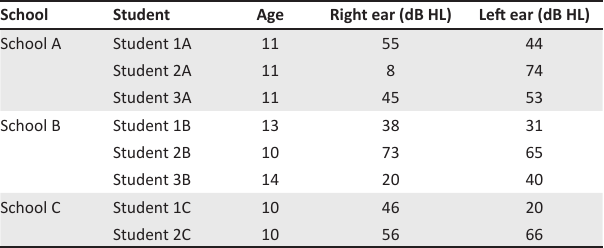
TABLE 1: Pure tone average for the frequencies 500 Hz, 1 kHz, 2 kHz and 4